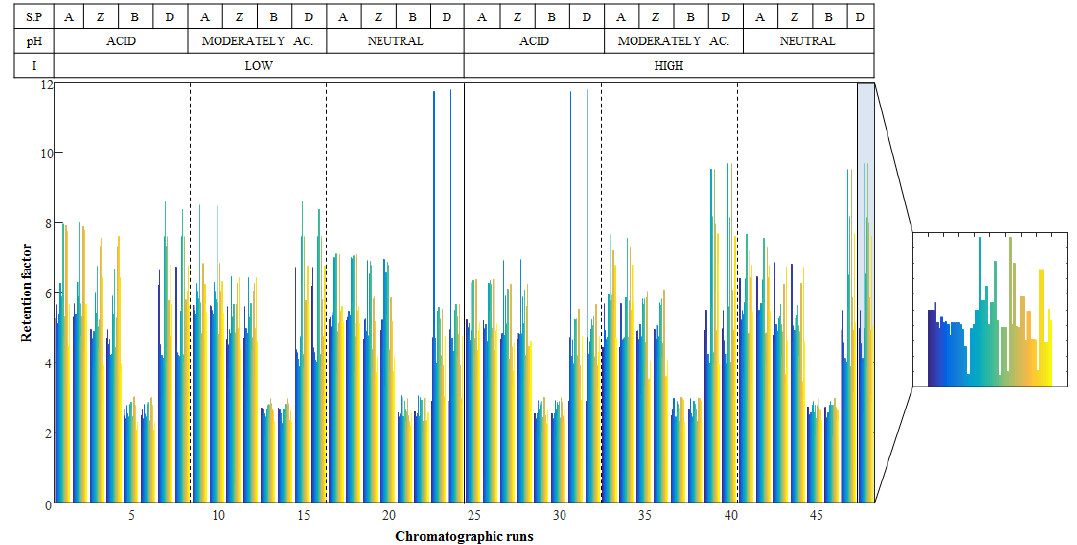
Figure 1. Retention factors for the 54 metabolites in the 48 chromatographic runs (matrix D ). The table on the top shows the chromatographic conditions of each sample: (A) indicates the chromatographic runs perfumed using amide, (Z) zwitterionic, (B) BEH amide and (D) mixed-mode diol stationary phases. As an example, a zoomed view of chromatographic run 48 is depicted. Table 1. Metabolites contained in the analyzed mixture.